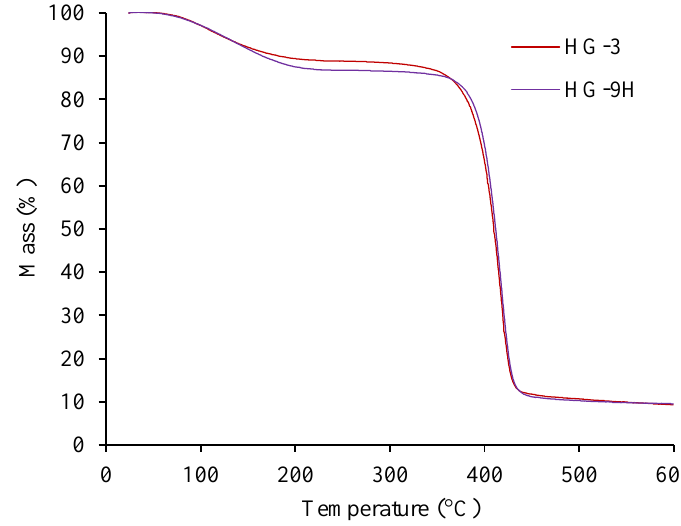
Figure 8. TGA curves of HG-3 and HG-9H (10 K/min under nitrogen atmosphere).